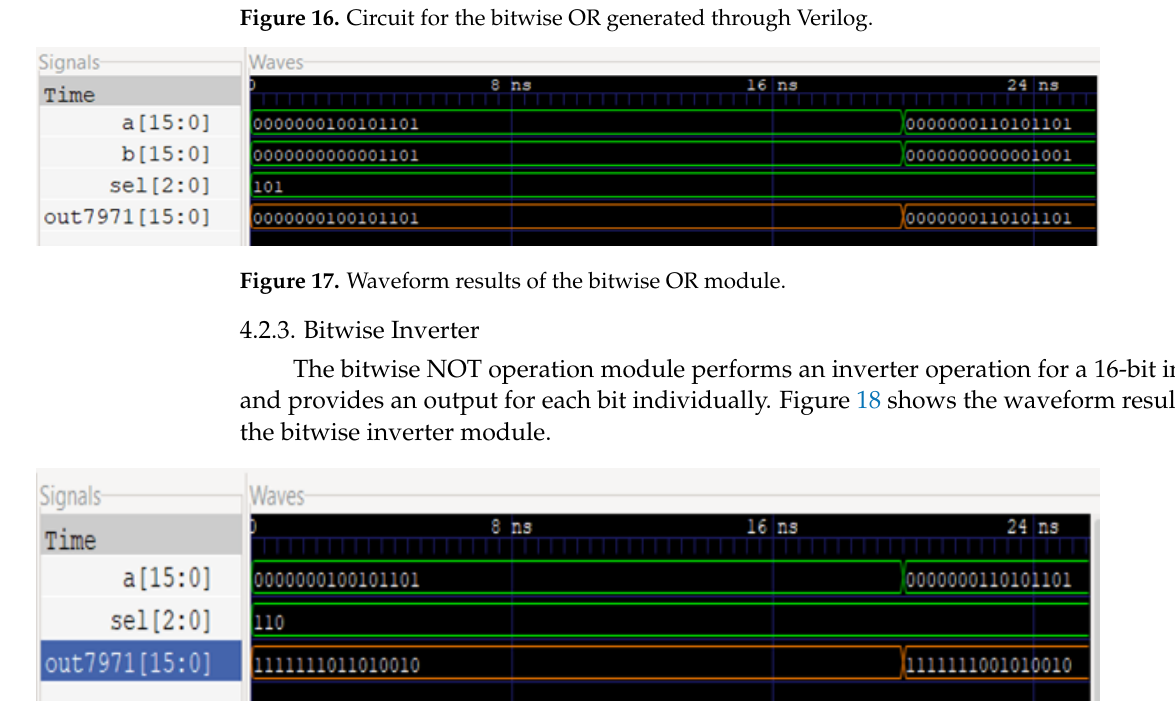
Figure 18. Waveform results of the bitwise inverter